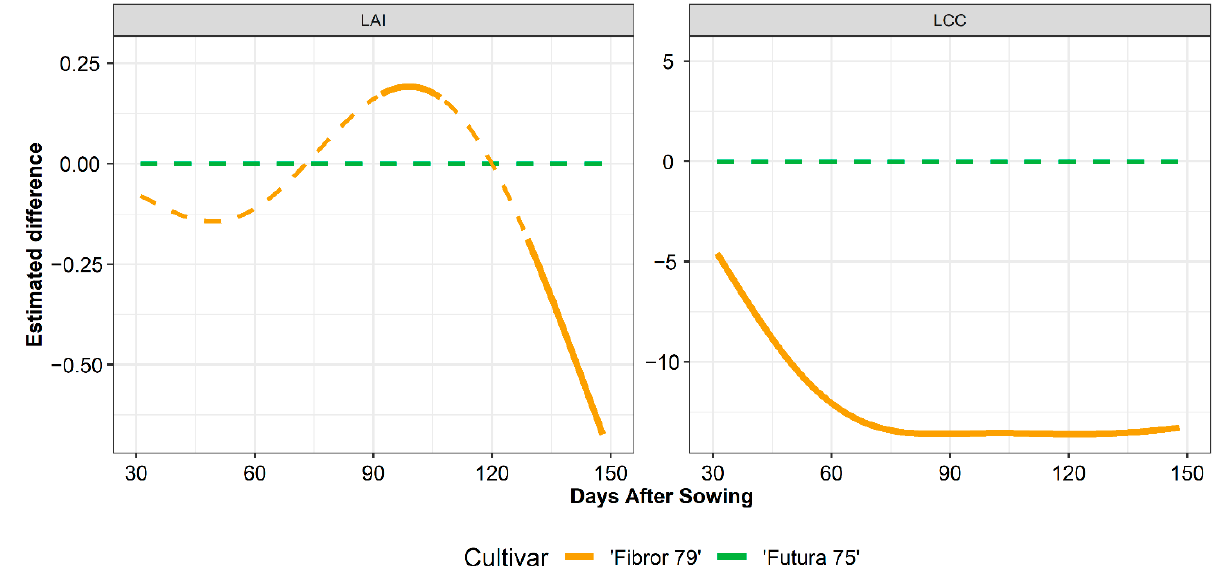
Figure 11. Traits’ dynamics of the two hemp cultivars according to the difference in estimated LAI and LCC. The dashed green line represents the reference cultivar “Futura 75” and the yellow line represents “Fibror 79”. The estimation of the differences between cultivars along the time series was carried out using a GAM. Solid and dashed yellow line denotes, respectively, significant ( p -value < 0.05) and not significant differences of “Fibror 79” compared to the reference “Futura 75”. A positive difference means that “Fibror 79” trait values were higher than "Futura 75”.